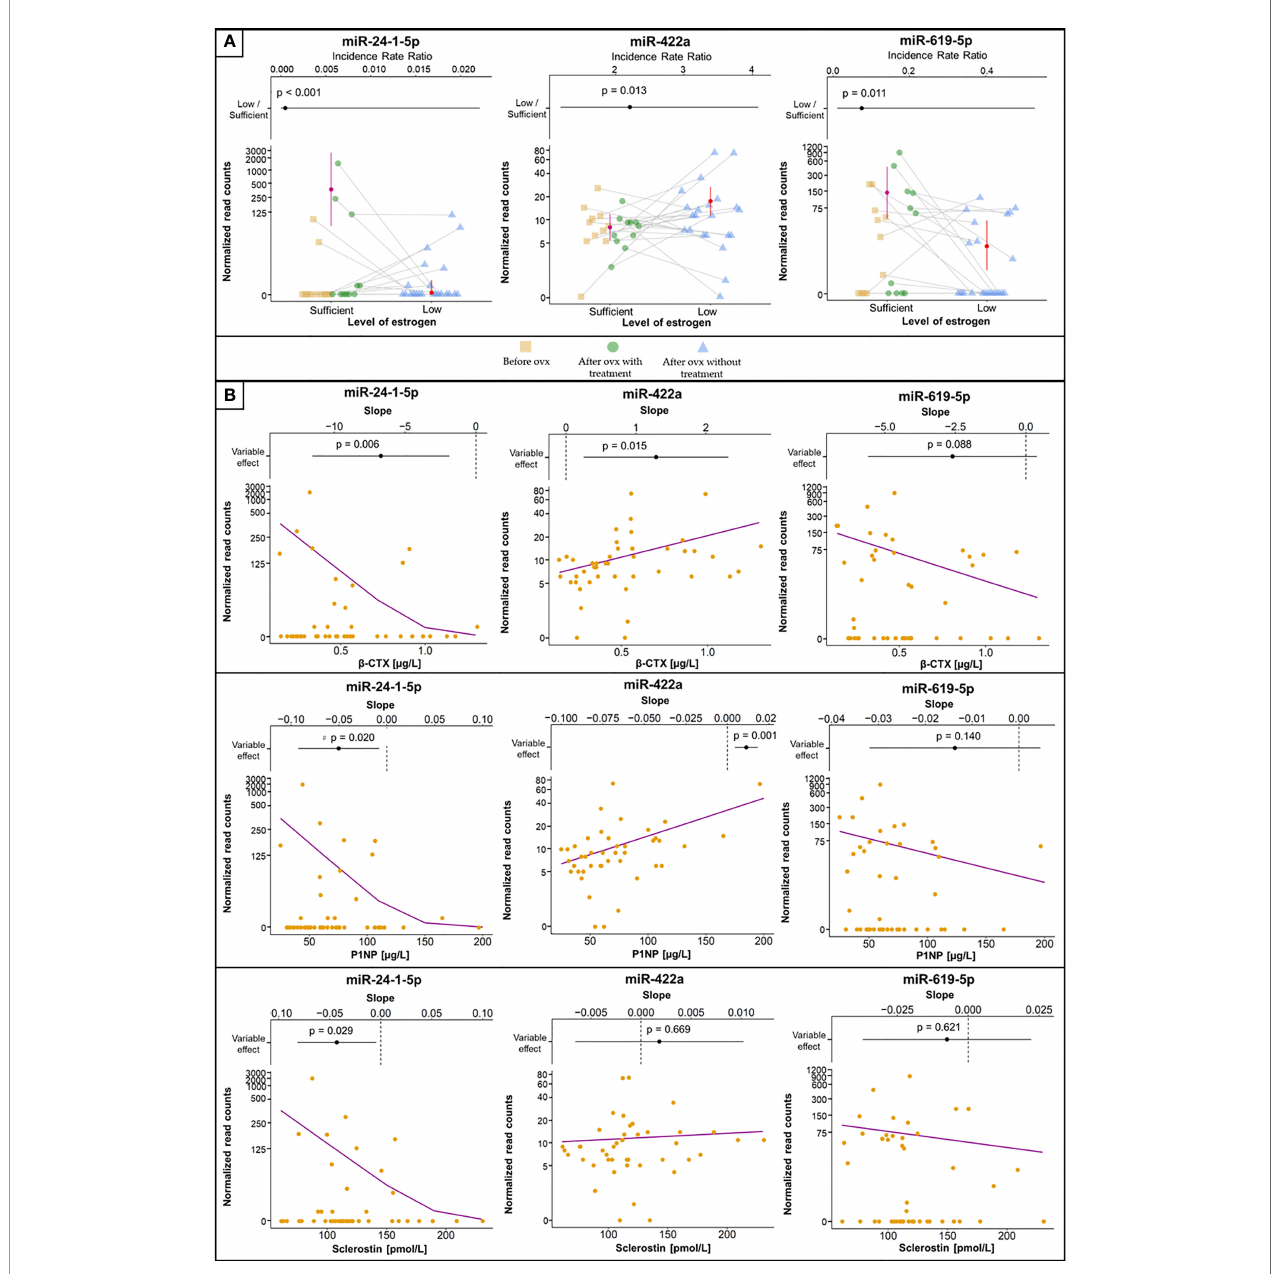
FIGURE 2 | Selected miRNAs associated with estrogen status and biomarkers of bone metabolism or in fl ammation. (A) MiRNA concentrations between groups, with error bars representing 95% con fi dence intervals and estimated means ( fi lled circles). Samples from the same patient are connected with grey lines. The plots at the top are visualizations of the 95% con fi dence intervals with IRR ( fi lled circles), where values > 1 indicate increased concentrations in samples with low estrogen levels and vice versa. The vertical dashed line indicates IRR equal to 1 (= no difference). p values denoting the statistical signi fi cance between the groups are speci fi ed above the slope and were computed using GLMM-NB. (B) The association of selected miRNAs with levels of biomarkers. The violet line is the regression line computed using GLMM-NB. The plots at the top are visualizations of 95% con fi dence intervals with the slope ( b ) ( fi lled circles), where a positive value indicates a positive association of the miRNA with the biomarker and vice versa. The vertical dashed line indicates a slope equal to 0 (= no difference). p values denoting the statistical signi fi cance of the association are speci fi ed above the slope and were computed using